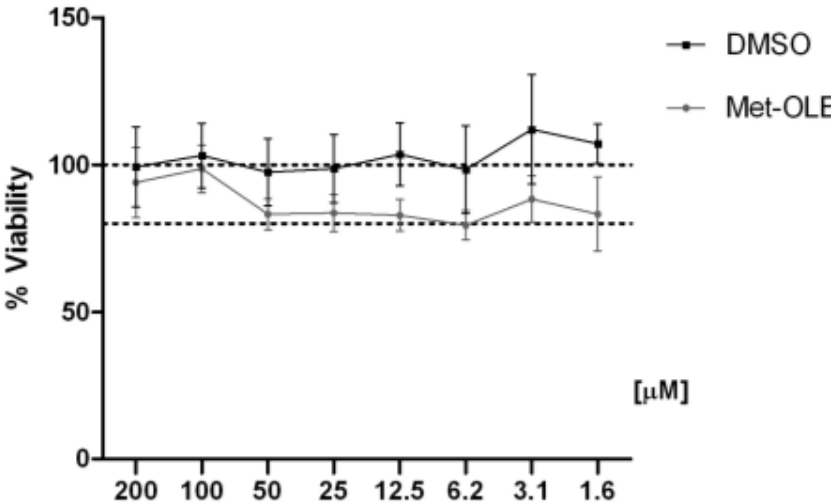
Figure 2. Effect of met-OLE on cell viability. Macrophages were pretreated with met-OLE (200–1.6 µ M) for 18 h. Cell survivals were expressed as the percentage of viability with respect to 100% from control, untreated cells. Results are presented as mean ± SEM of at least six independent